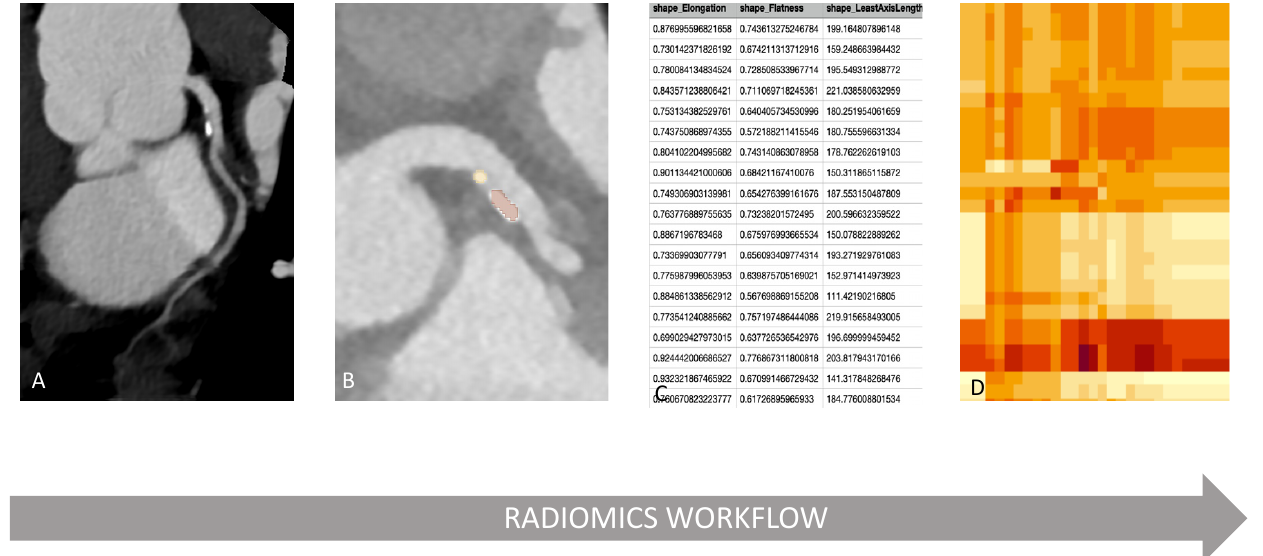
Figure 1. Example of radiomics workflow . A high-quality CCTA image ( A ) is the foundation for radiomics application. After segmentation of the region of interest (plaques marked in yellow and orange ( B ), features can be extracted using dedicated software (parameters of various radiomics features ( C ). Features are selected in dependence on i.e., clinical parameters and models can be created further, for example by creating a heatmap ( D ).